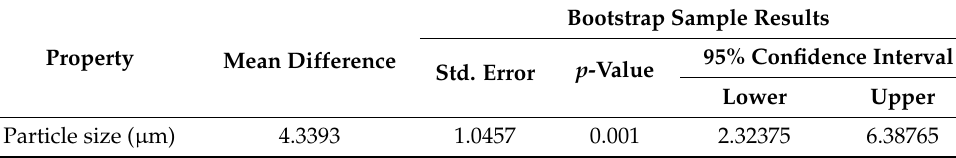
Table 8. Particle size analysis